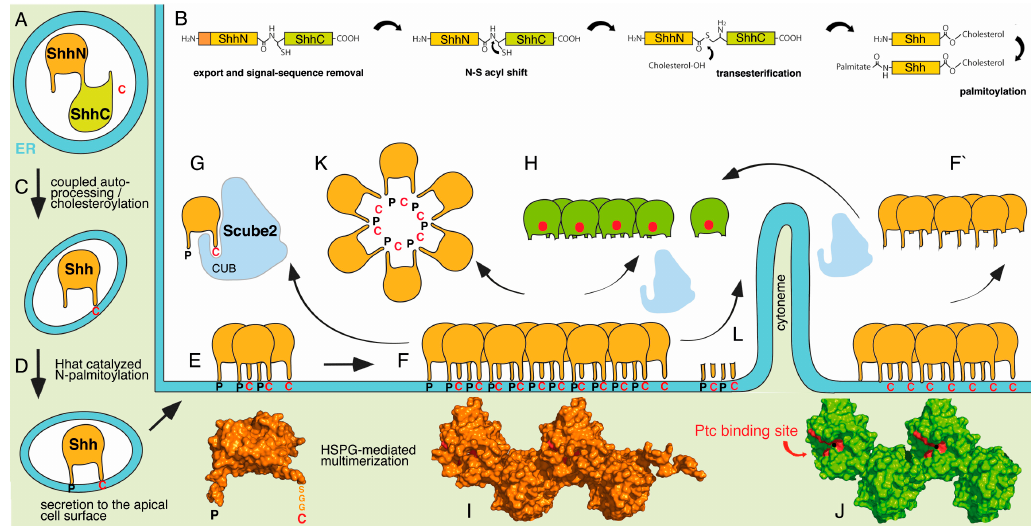
Figure 1. Biosynthesis and release models of dual-lipidated Hh, using vertebrate Shh as an example. The 45 kDa ShhNC precursors are secreted into the ER and their signal sequence is processed ( A ). This is followed by cholesterol esterification of the C-terminal peptide by intein-related autoprocessing/cholesterol esterification ( B , C ). Subsequent palmitoylation of N-terminal peptides is catalysed by Hhat. This generates bioactive dual-lipidated Shh ( D ). After export to the cell surface, Shh firmly tethers to the outer membrane leaflet of the plasma membrane ( E ) and generates large clusters ( F ), using cell-surface-associated HSPGs as scaffolds (not shown for clarity). Crystal lattice interactions, biochemical assays and in vitro cell culture assays suggested that N-terminal peptides of one molecule in the cluster block Ptc receptor binding sites (red) of its neighbour, rendering the molecule inactive. Several Shh release mechanisms have been proposed: direct, Scube2-mediated cholesterol extraction from the membrane ( G ), proteolytic processing of both lipidated peptides ( H ), micelle formation ( K ) or Hh piggybacking on exosomes or lipoprotein particles and transport on extended, filopodia-like structures called cytonemes ( L ). Note that one way to explain strongly reduced bioactivity of non-palmitoylated Shh is that proteolytic processing of Shh N-termini is impaired during release, resulting in soluble clusters with their receptor binding sites still blocked ( F’ , I ). Proteolytic processing, in contrast, reverses the Ptc blockade by N-terminal peptides in the cluster ( J ) and thereby activates the protein. The Scube2-assisted in vitro conversion of inactive unprocessed Shh into truncated fully bioactive Shh supported this mechanism ( F – H ). I, J: Tetrameric Shh crystal lattice interactions as part of a larger extended structure are shown. P: palmitate, C: cholesterol.